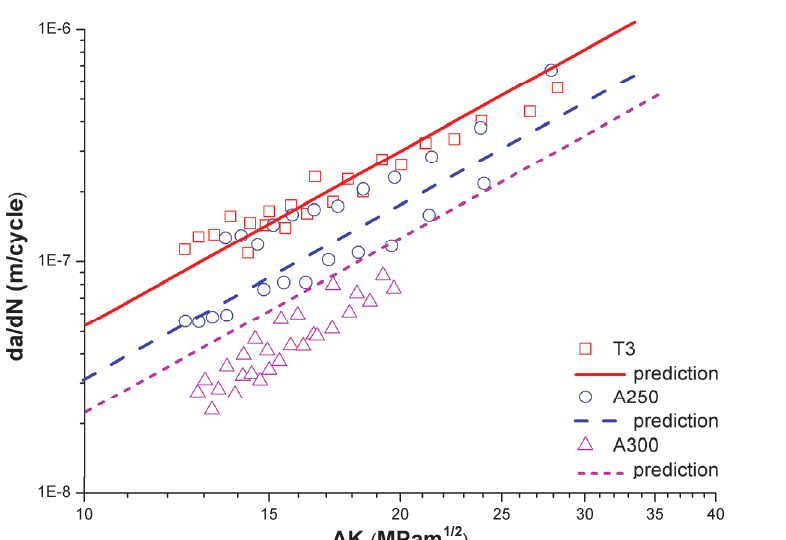
Figure 7: Experimental and computed fatigue crack growth rates vs. stress intensity factor range (d α /dN- ΔΚ ) in T3, A250 and A300 materials evaluated for r c,mean =1.329x10 -6